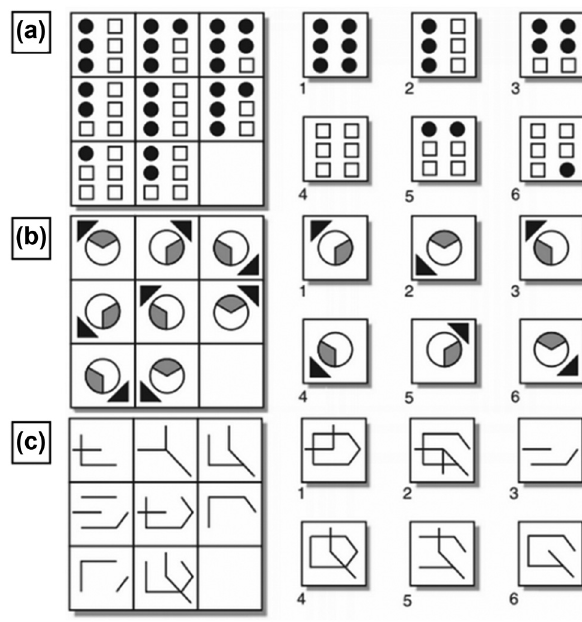
Figure 1: Example of matrices for easy ( a ) , medium ( b ) , and hard ( c )